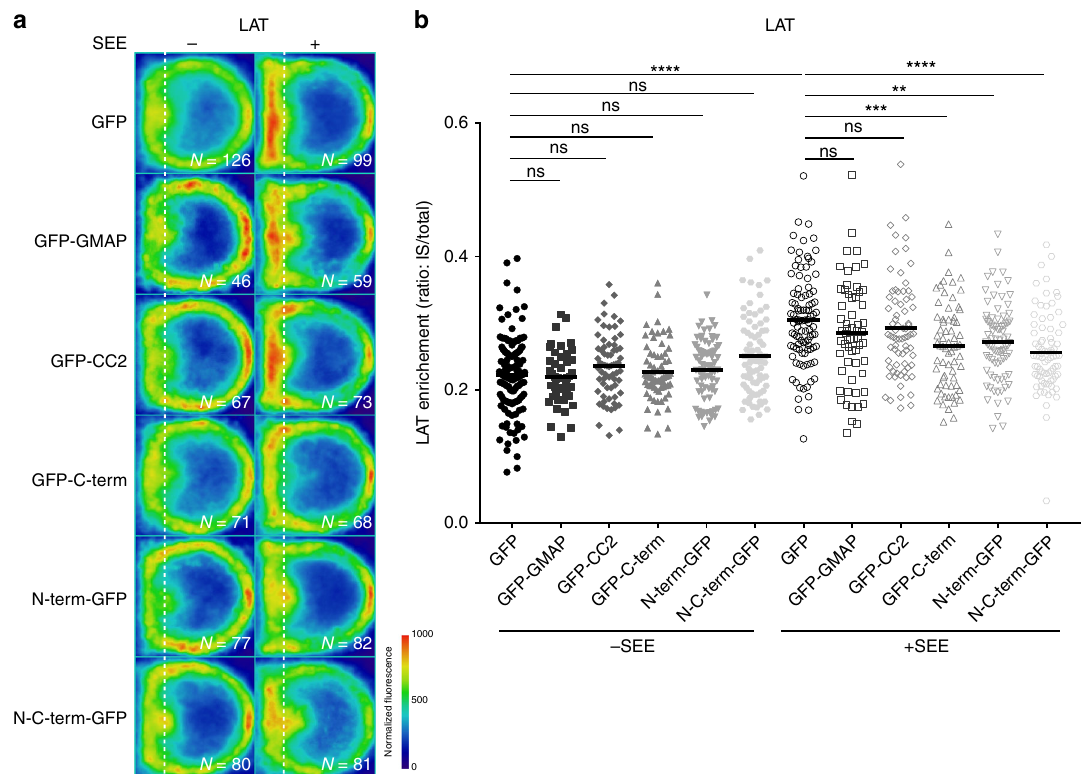
Fig. 7 GMAP210 tethering activity controls LAT recruitment at the immune synapse. a , b Confocal images (left panels) and quanti fi cation (right panels) of the enrichment of LAT ( a , b ) at the immune synapse (depicted by the dotted white line) in Jurkat “ mean cells ” expressing GFP alone, GMAP210-GFP, or different GMAP210 domains coupled to GFP and interacting for 30 min with Raji cells left unpulsed ( − , unactivated state) or pulsed with SEE ( + , immune synapse formation). N = number of cells constituting the mean image. Horizontal line represents median. ** P < 0.01, *** P < 0.001, **** P < 0.0001, ns: non- signi fi cant (one-way ANOVA). Data are representative from two independent